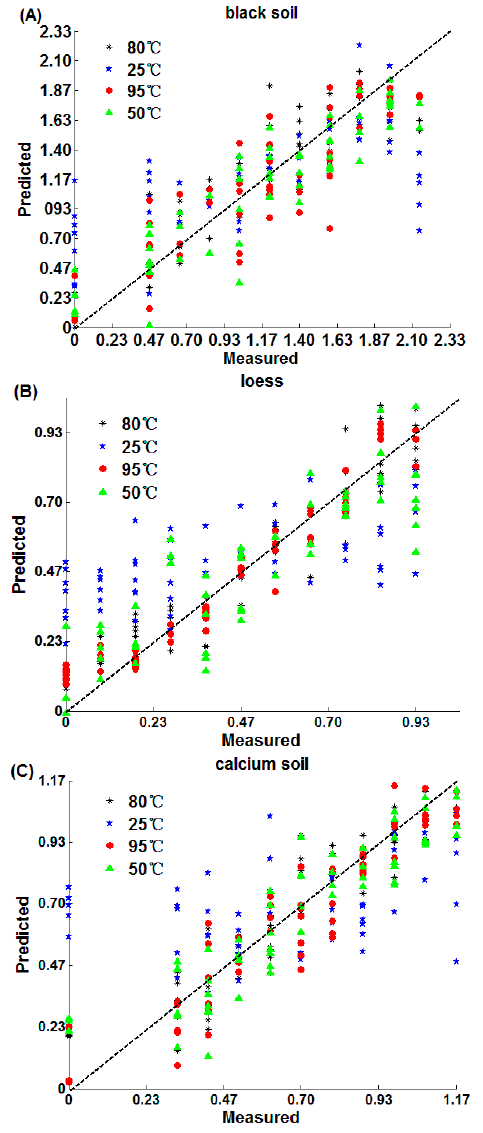
Figure 7. CARS prediction results: ( A ) black soil; ( B ) loess; ( C ) calcium soil. Table 5. The modeling results of different soils and temperatures by CARS.